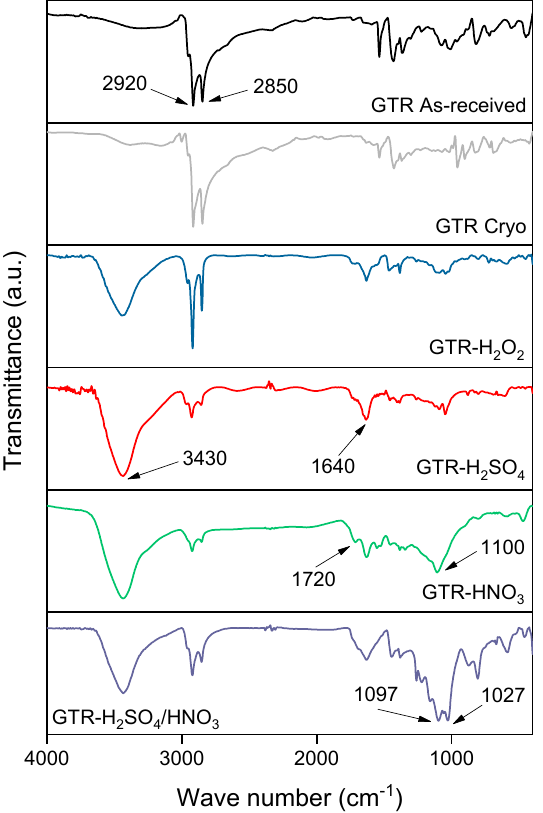
Figure 4. Fourier-transform infrared (FTIR) spectra of as-received, cryo-ground (GTR Cryo), and chemically treated GTR.